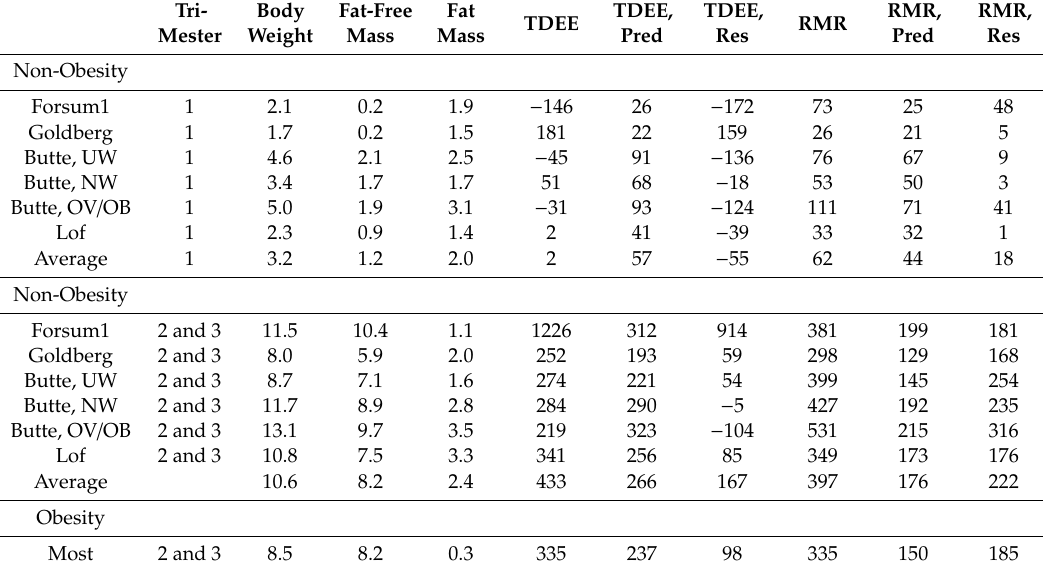
Table 2. Summary of changes in body mass, composition and energy expenditure, proportional and independent of body weight